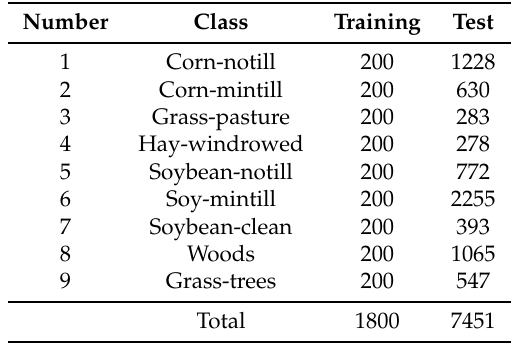
Table 2. Number of training (labelled) samples and test (unlabelled) samples in the Indian Pines